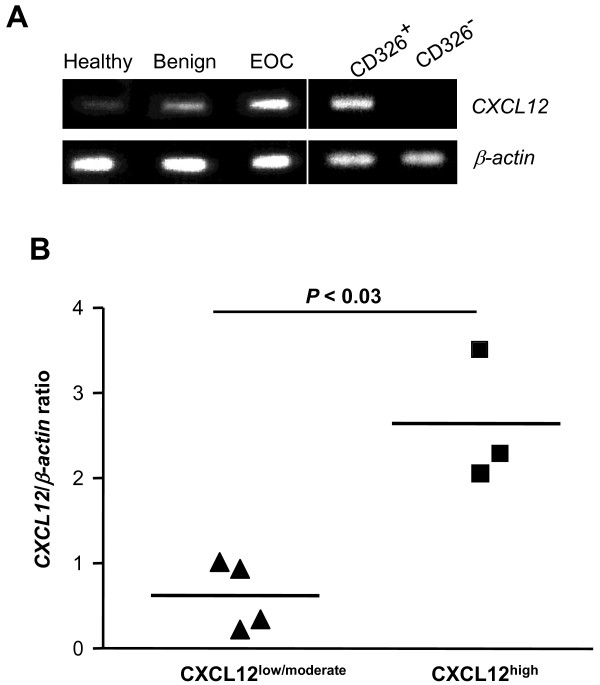
Steady-state levels of CXCL12 transcripts in healthy and malignant ovarian tissues. (A) CXCL12 mRNA was detected by conventional PCR and was of the expected size (417 bp) in healthy ovaries (faint signal), benign and invasive ovarian tumors (strong signal) and in CD326+ epithelial cell-enriched malignant ascites samples. By contrast, CXCL12 transcripts were absent from CD326- non epithelial cells. The results presented are from one experiment representative of three carried out. The white vertical line separates lanes not run on the same gel. (B) CXCL12 mRNA levels were quantified by real-time PCR and are expressed as CXCL12/β-actin ratios. The diagram shows the distribution of values and means for EOC samples identified as CXCL12high and CXCL12low/moderate. Each symbol represents an individual sample run in duplicate. The P value presented is that for a two-tailed Student's t test.